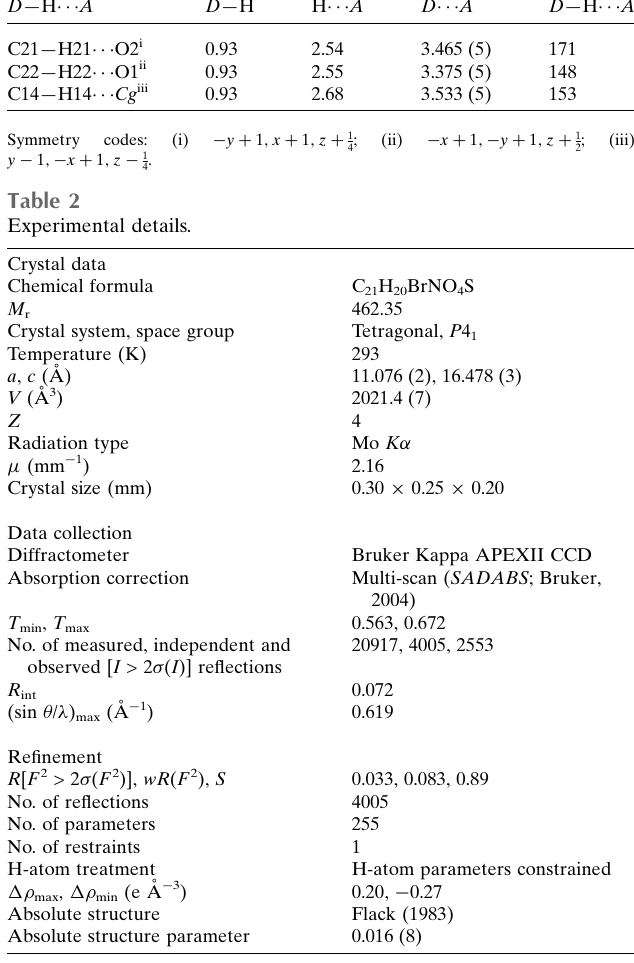
Table 1 Hydrogen-bond geometry (A˚ , (cid:3) ). Cg is the centroid of the C18–C23 ring.